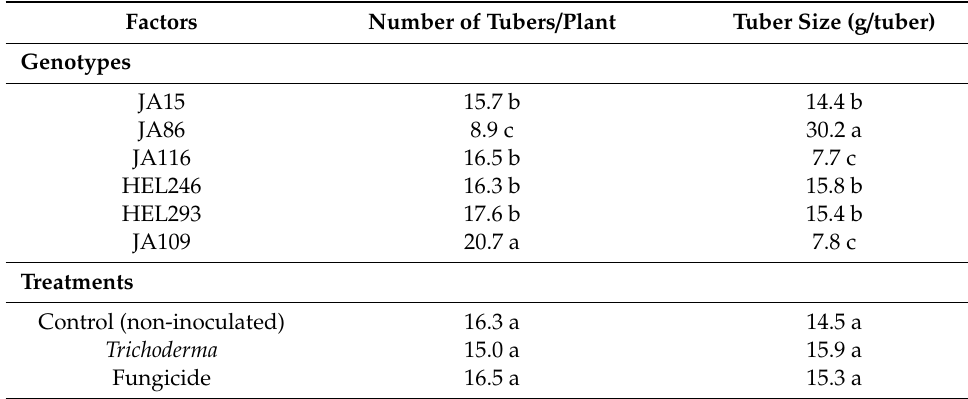
Table 4. Means of the number of tubers per plant and tuber size (g / tuber) averaged over two fertilization regimes of six Jerusalem artichoke genotypes and three control